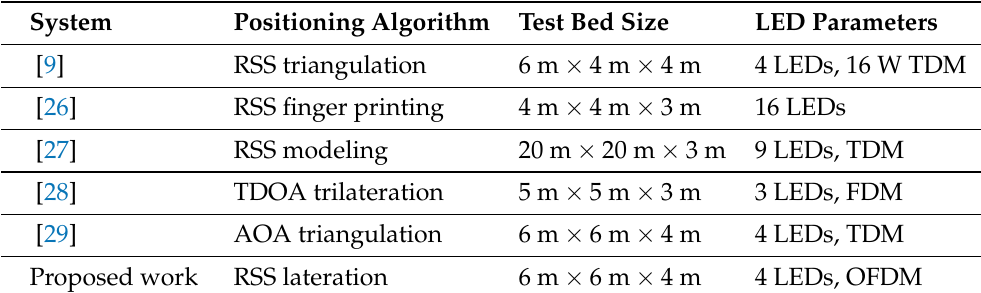
Table 1. Analysis of PD-based indoor VLC